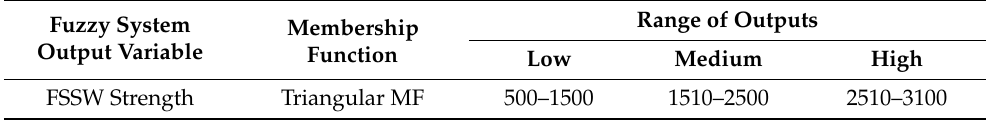
Figure 12. Outputs of FSSW strength fuzzy system. Table 7. Membership functions of FSSW strength fuzzy system outputs.